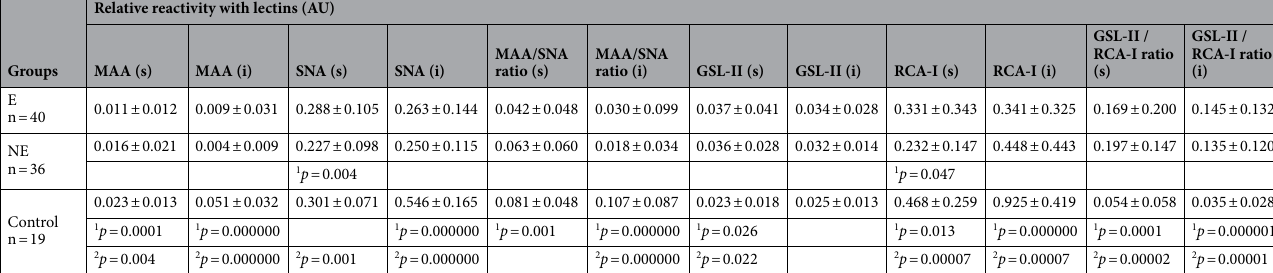
Table 1. Relative reactivity of s-IgG and i-IgG glycans with specific lectins. The results are expressed in absorbance units (AU) as mean values ± SD. Serum IgG glycan reactivities with lectins were estimated by direct lectin-ELISA and expressed in absorbance units (AU). MAA: Maackia amurensis agglutinin, recognizing sialic acid α2,3-linked; SNA: Sambucus nigra agglutinin, recognizing sialic acid